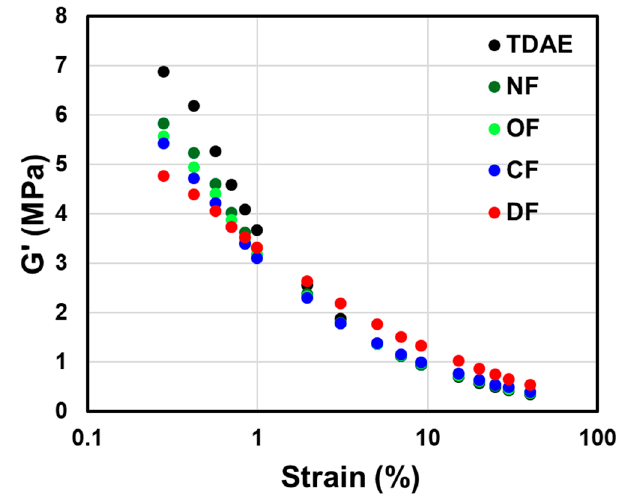
Figure 5. Storage modulus (G ′ ) of the uncured compounds according to the applied processing